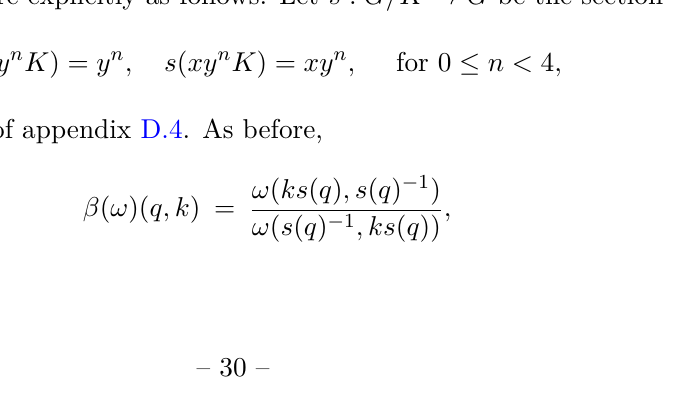
table 10, the genus-one phases are not invariant under x 2 : for example, (cid:15) (1 , y ) 6 = (cid:15) ( x 2 , y ) , and so ω cannot be a pullback from H 2 ( Z